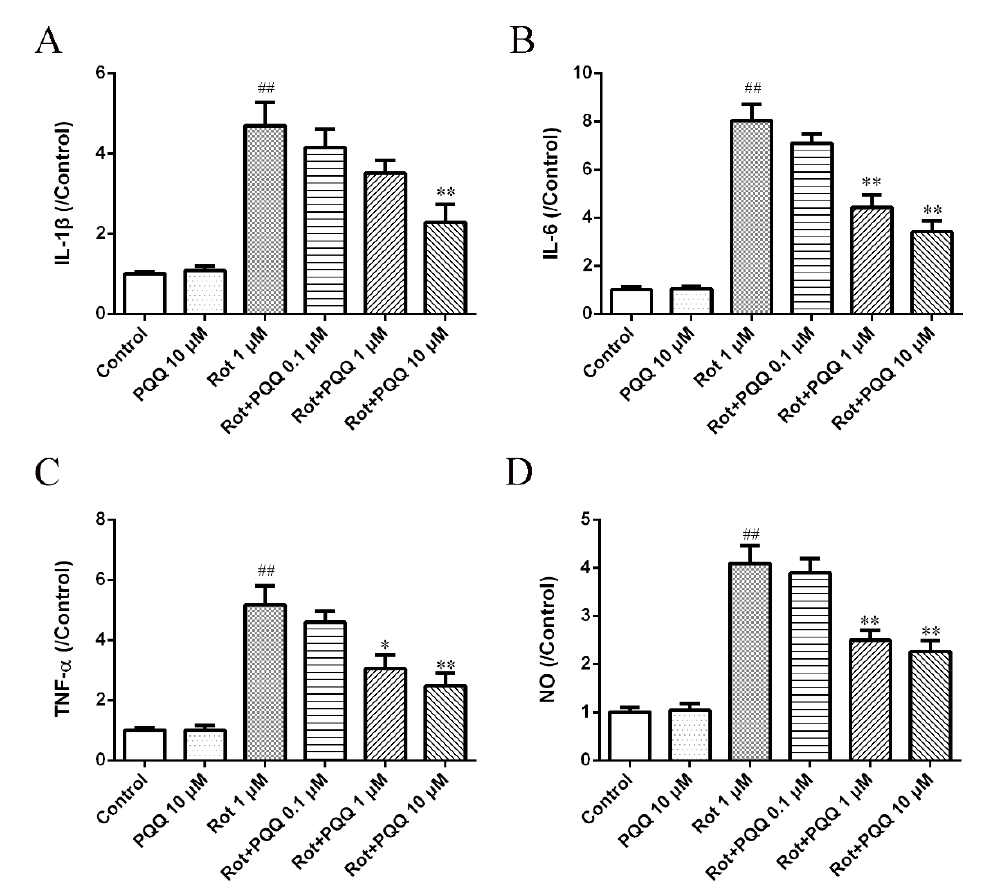
Figure 2. PQQ suppressed rotenone-induced pro-inflammatory cytokine and NO release in BV2 microglial cells. BV2 microglia cells were pre-treated with di ff erent doses (0.1, 1, 10 µ M) of PQQ for 2 h before rotenone (1 µ M) incubation for another 12 h. The levels of interleukin-1 β (IL-1 β ) ( A ), IL-6 ( B ) and tumor necrosis factor- α ((TNF- α ) ( C ) in the cultured media were measured by enzyme-linked immunosorbent assay (ELISA) assays. ( D ) Nitric oxide (NO) release in the cultured medium was measured. The data were presented as the mean ± SEM from four independent experiments. * p < 0.05, ** p < 0.01 vs. rot group; ## p < 0.01 vs. control group.